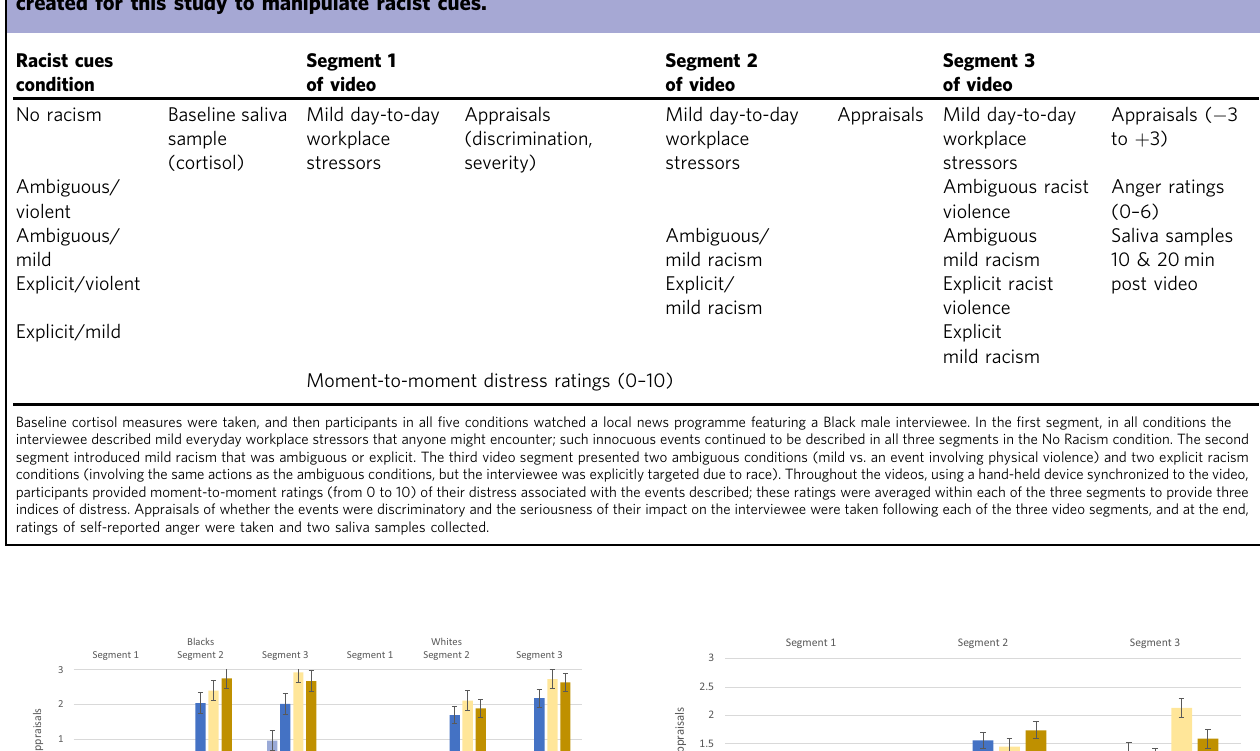
Table 1 The experimental study entailed Black ( n = 99) and White ( n = 112) participants assigned to watch one of fi ve videos created for this study to manipulate racist cues.